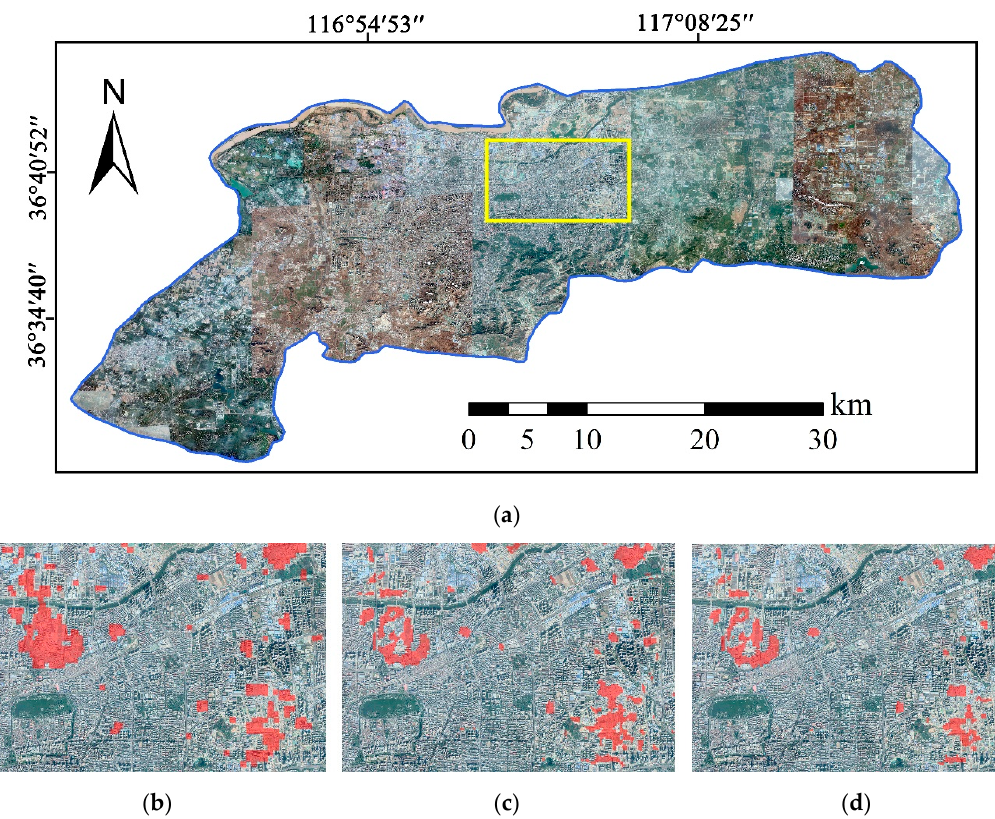
Figure 10. ( a ) The whole study area; mapping result of green plastic cover using ( b ) Sentinel-2 data; ( c ) Google Earth data; ( d ) refined result.